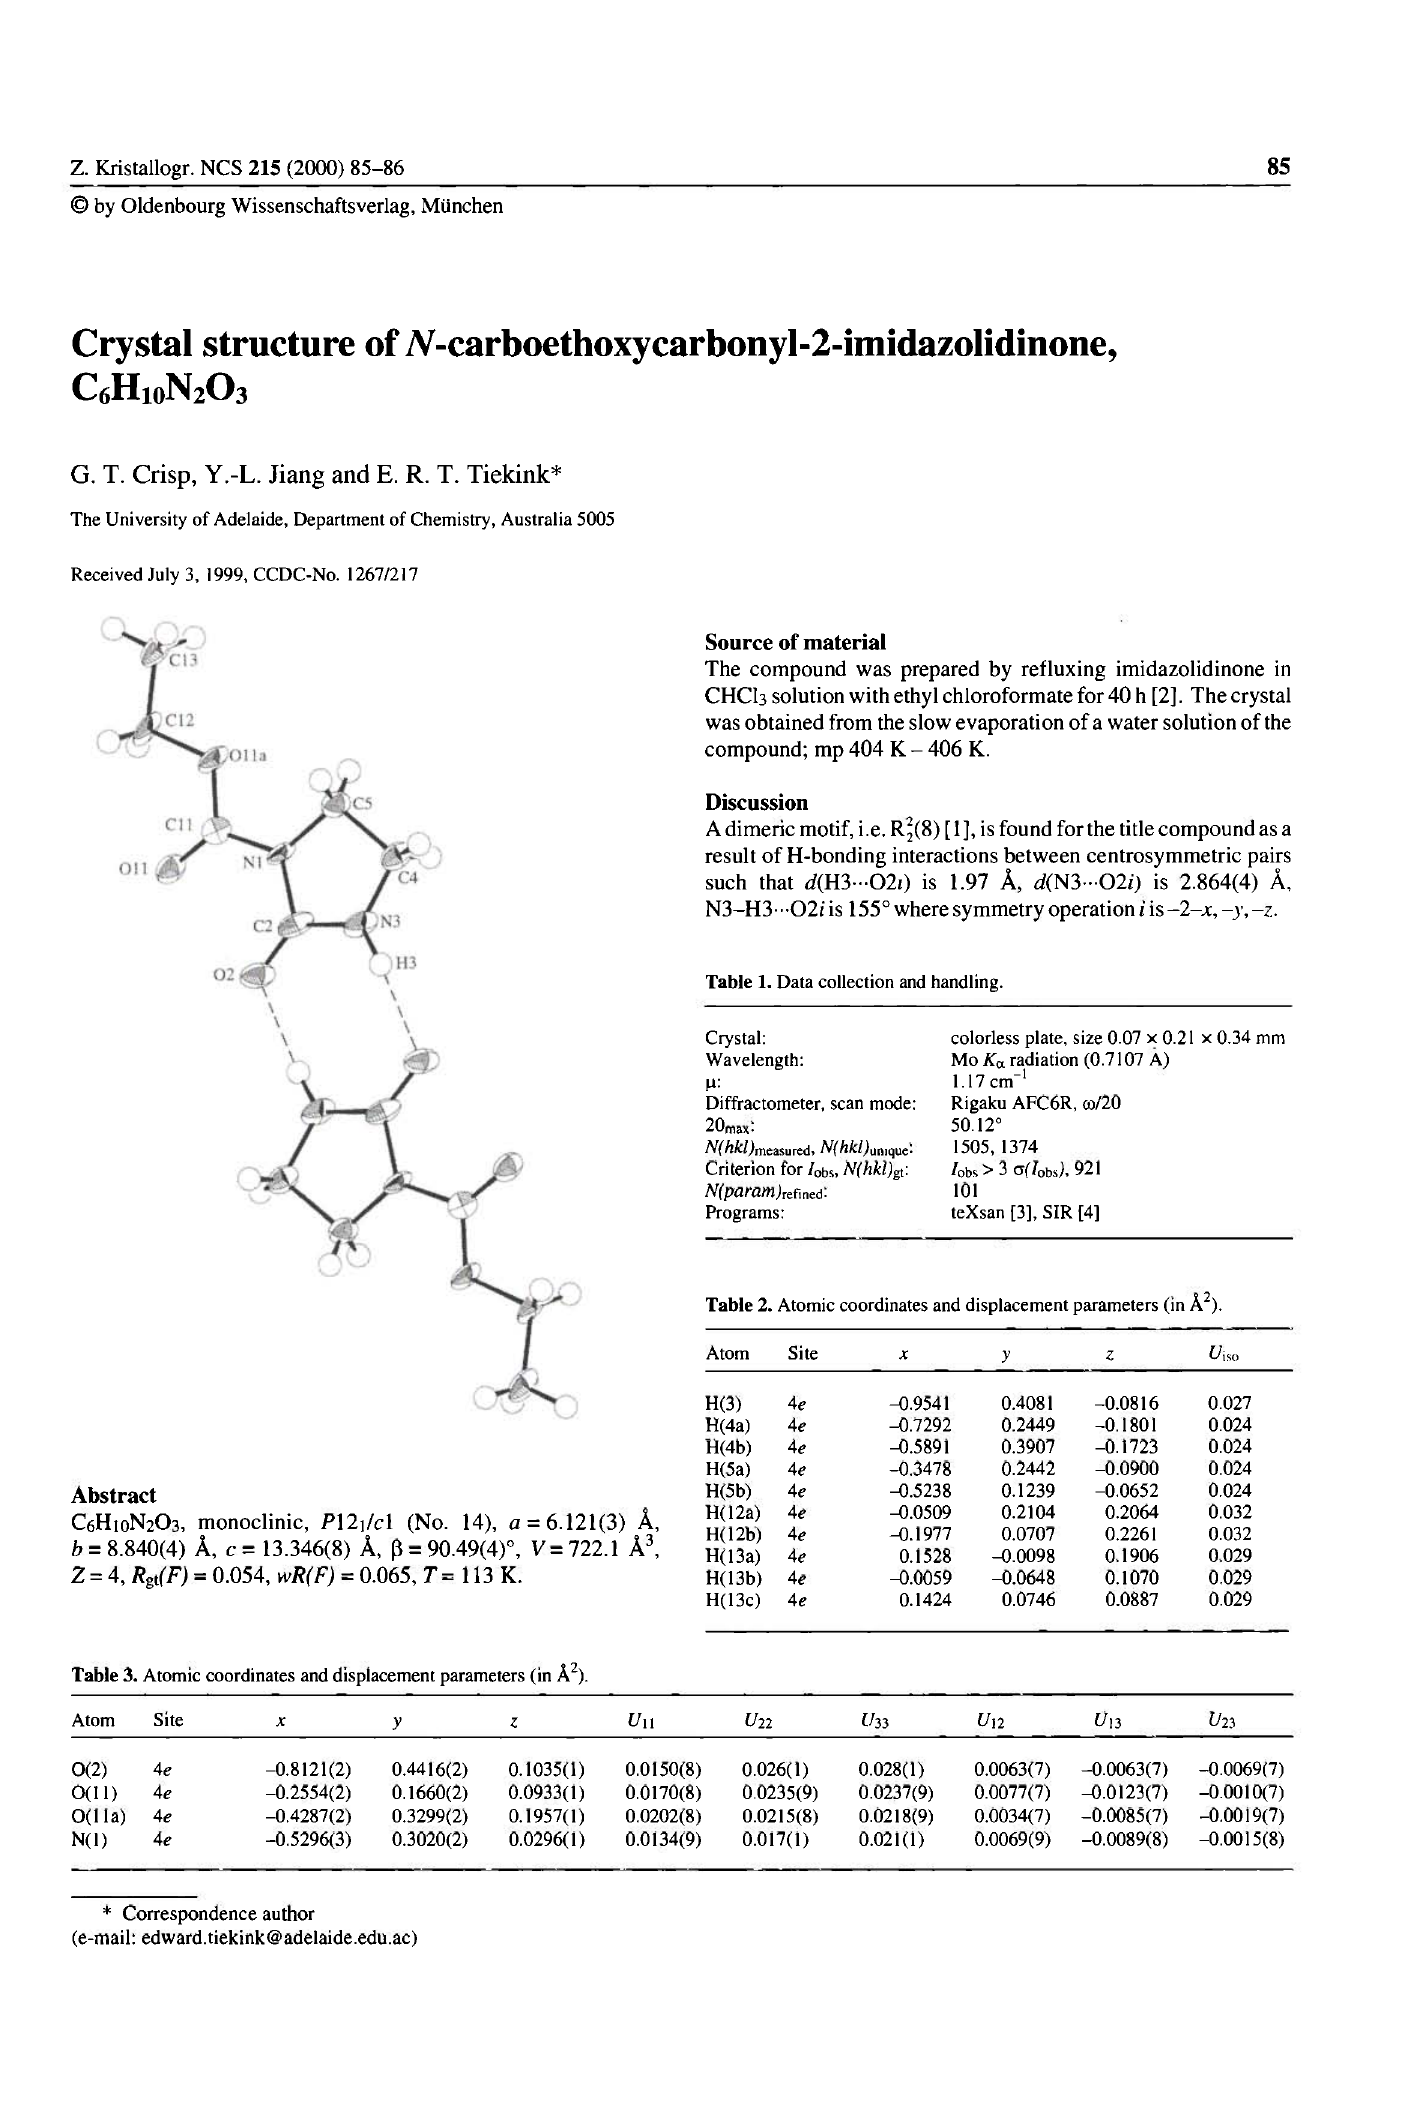
Table 3. Atomic coordinates and displacement parameters (in Ä 2 ).